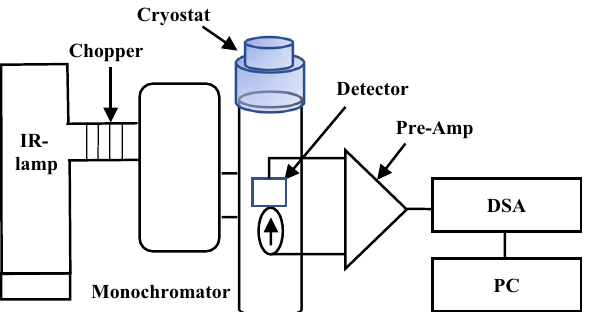
Figure 5. A schematic showing the spectral Responsivity and Detectivity testing setup.